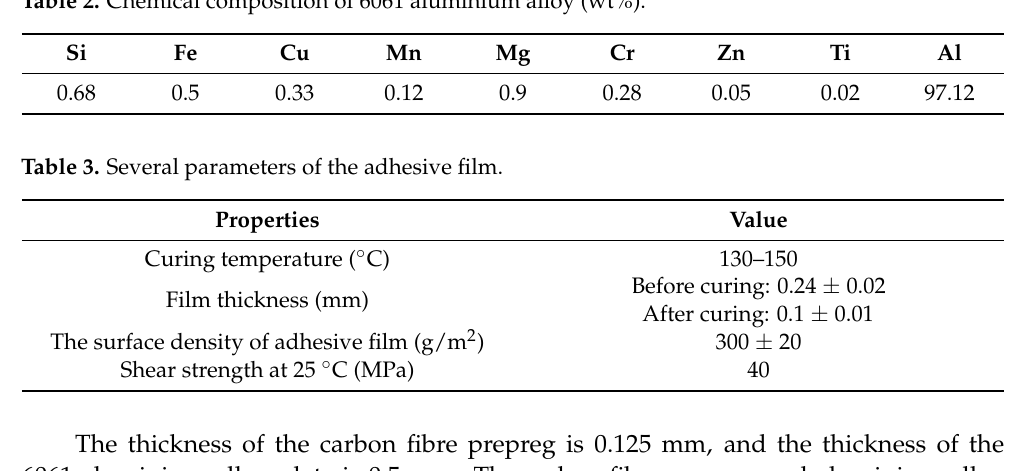
Table 2. Chemical composition of 6061 aluminium alloy (wt%).